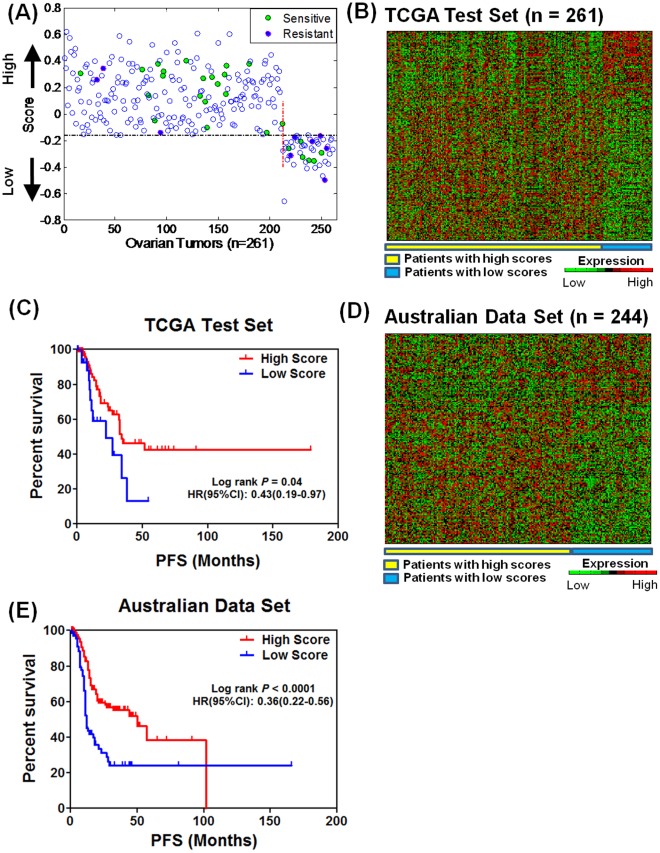
Validation of gene signature.(A) The predictive model constructed from the TCGA training set was applied to an independent TCGA validation set (n = 261) and split the patients into two groups based on the score cutoff of −0.16 as determined by the ROC curve. Thirty five patients are identified to have an explicit response to chemotherapy [22]. (B) The two groups are well separated, with 212 patients in the low-scoring group and 49 in the high-scoring group. (C) Exclusion of patients with no survival data resulted in 109 patients in the low-scoring group and 29 in the high-scoring group. Kaplan-Meier analysis shows patients in the high-scoring group had poorer progression-free survival (P = 0.04). (D) The predictive model as applied to the external data set distinguishes the patients in the low-scoring group from in the high-scoring group; where the low-scoring group consists of the 70.1% patients (171 out of 244) with the highest predictive scores, and the high-scoring group consists of the 29.9% patients (73 out of 244) with the lowest predictive scores (see text for details). (E) Kaplan-Meier analysis shows patients in the high-scoring group had poorer progression-free survival than those in the low-scoring group (P<0.0001).